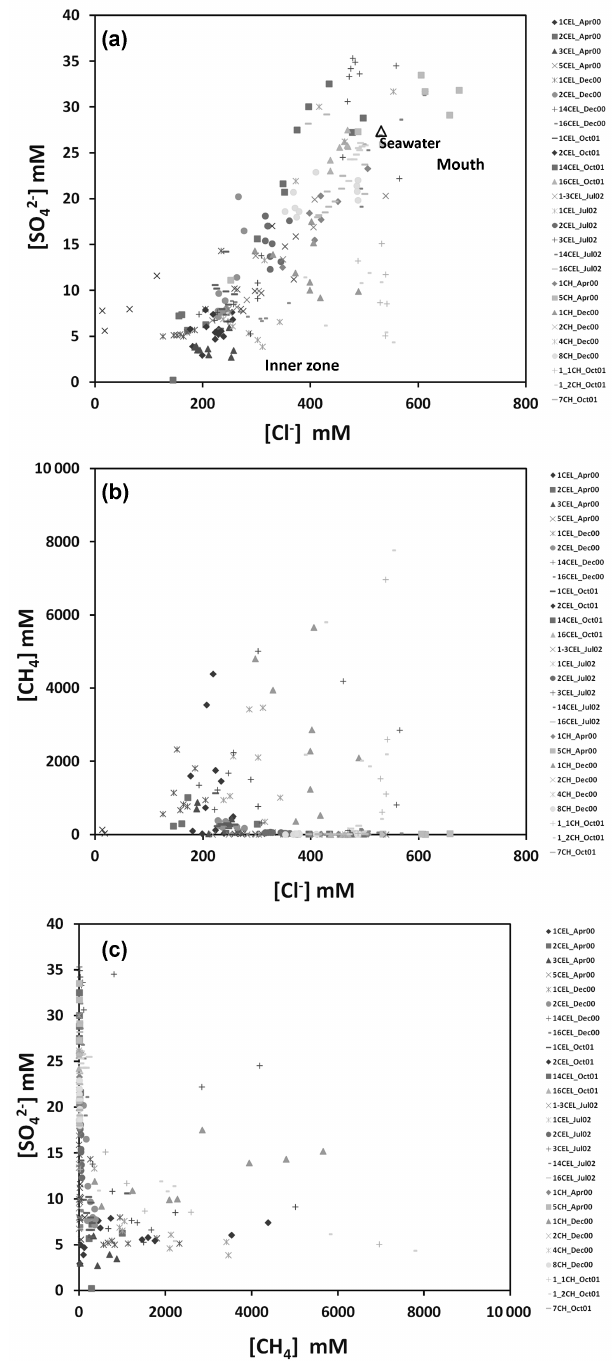
Figure 3. Relationship between (a) [Cl − ] and [SO 2 − and [CH 4 ] and (c) [CH 4 ] and [SO 2 −